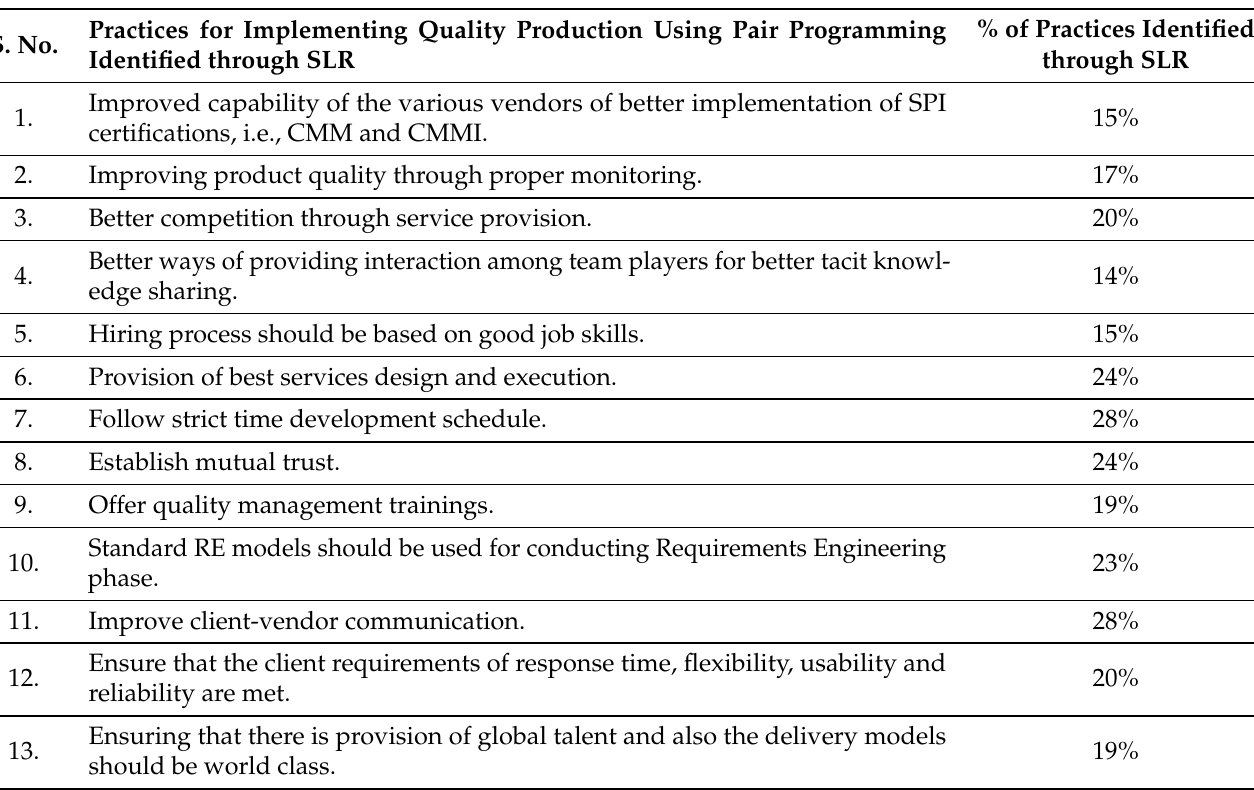
Table 18. Practices for implementing quality production using pair programming.